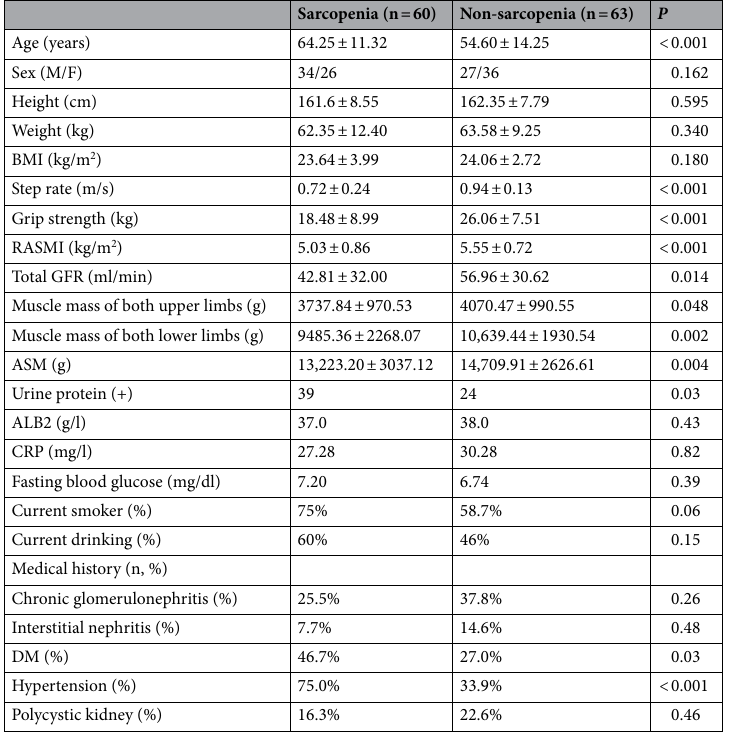
Table 2. Comparison of the general characteristics between the sarcopenic and non-sarcopenic patients in the CKD population. ASM appendicular skeletal muscle, BMI body mass index, RASMI relative appendicular